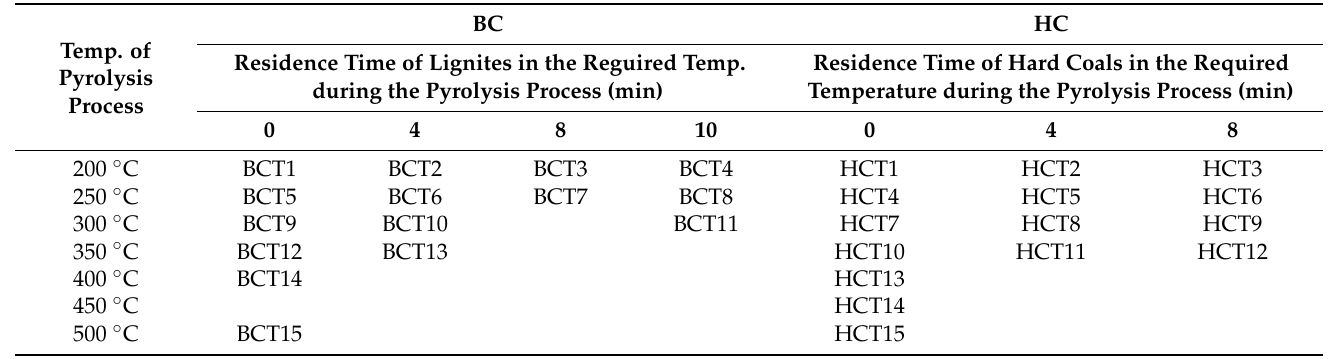
Table 3. Experimental temperature ranges for testing and residence time impact on Hg removal content from lignite (BC1, BC2) and hard coals (HC1, HC2, HC3).